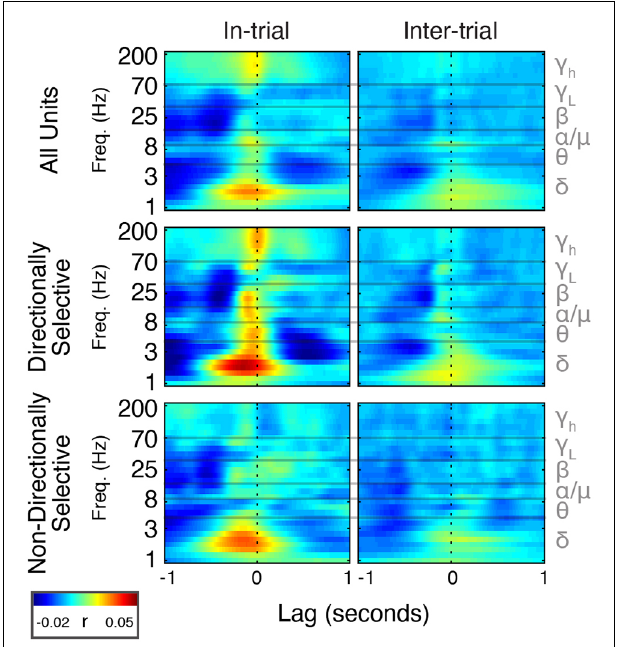
FIGURE 8 | Spike timing is correlated with power modulation in specific frequency bands. Average cross-correlation between individual unit spike density estimates (SDEs) and FP power at different frequencies expressed as a heat map. t = 0 indicates a zero-lag correlation. Negative lags indicate that spikes lead FP changes, and positive lags indicate that FP changes lead spiking.